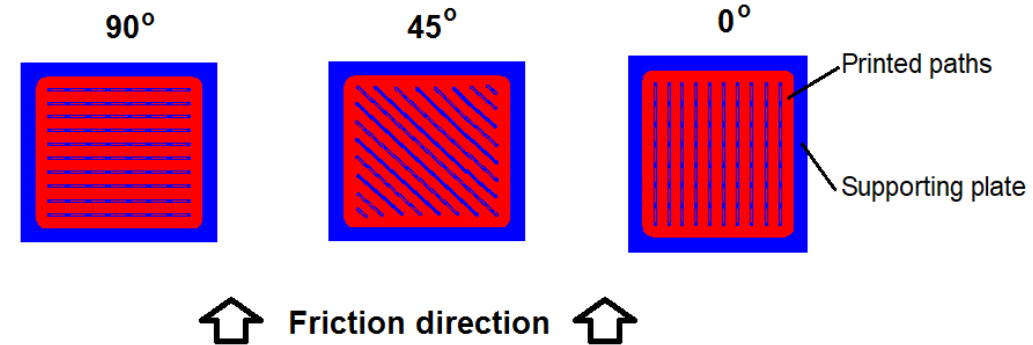
Figure 1. 3D printout with possible anisotropy vs. friction direction.